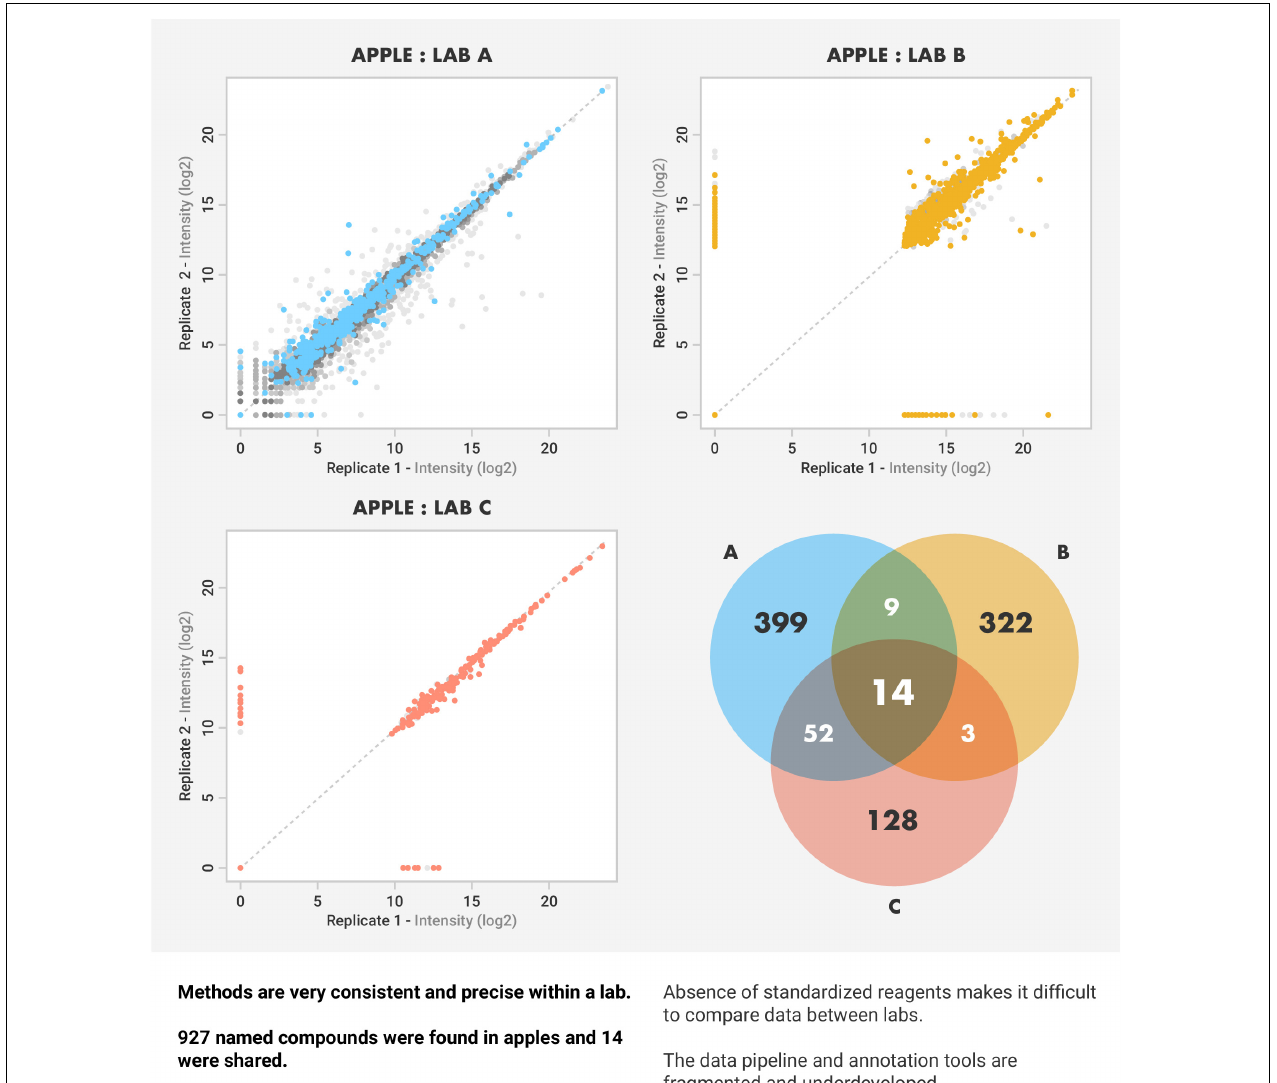
FIGURE 2 | Variability of apple analytes across labs. The Periodic Table of Food Initiative sent identical apple reference sample material to three high-profile laboratories and found tremendous variation in the analytes identified and annotated between the labs. These findings highlight the lack of standardization in food composition analysis while calling for the need for standardized pipelines for analysis and data